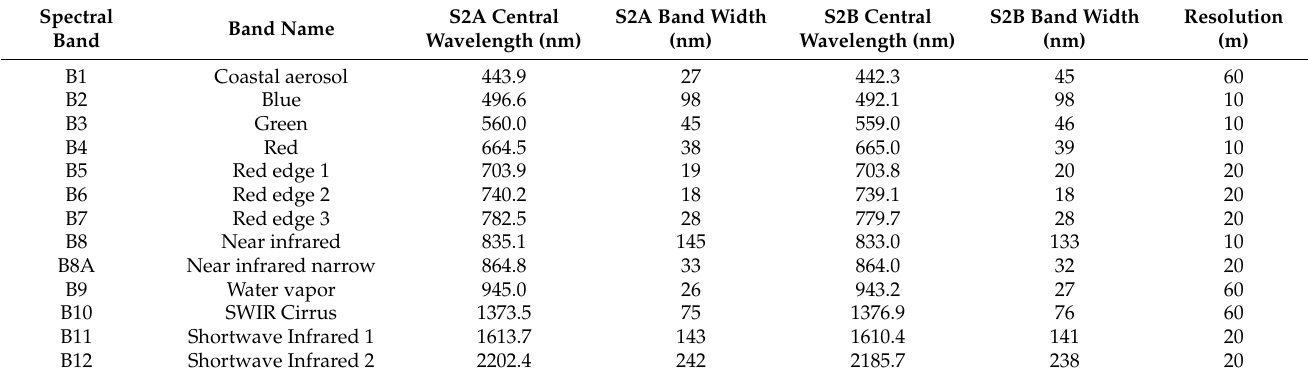
Table A2. Spectral characteristics of Sentinel-2 MSI sensor.